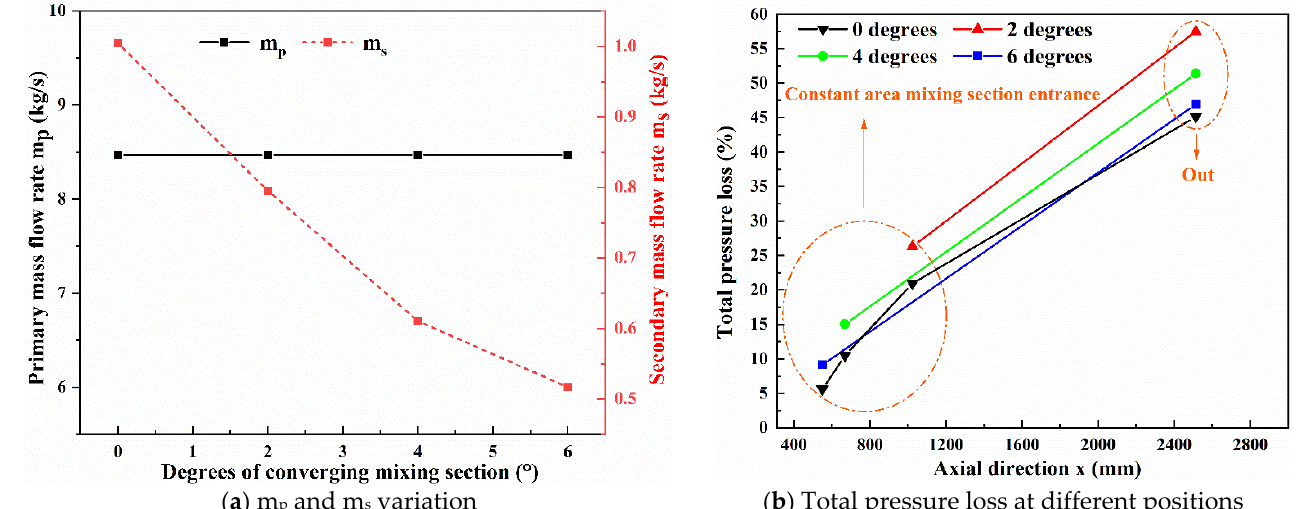
Figure 16. Contraction angle( φ ) at different mixing chambers: ( a ) variation trend of primary and secondary flow rates; ( b ) total pressure loss at the inlet and outlet sections of the secondary throat (When φ = 0°, each cross section at the corresponding position is taken).